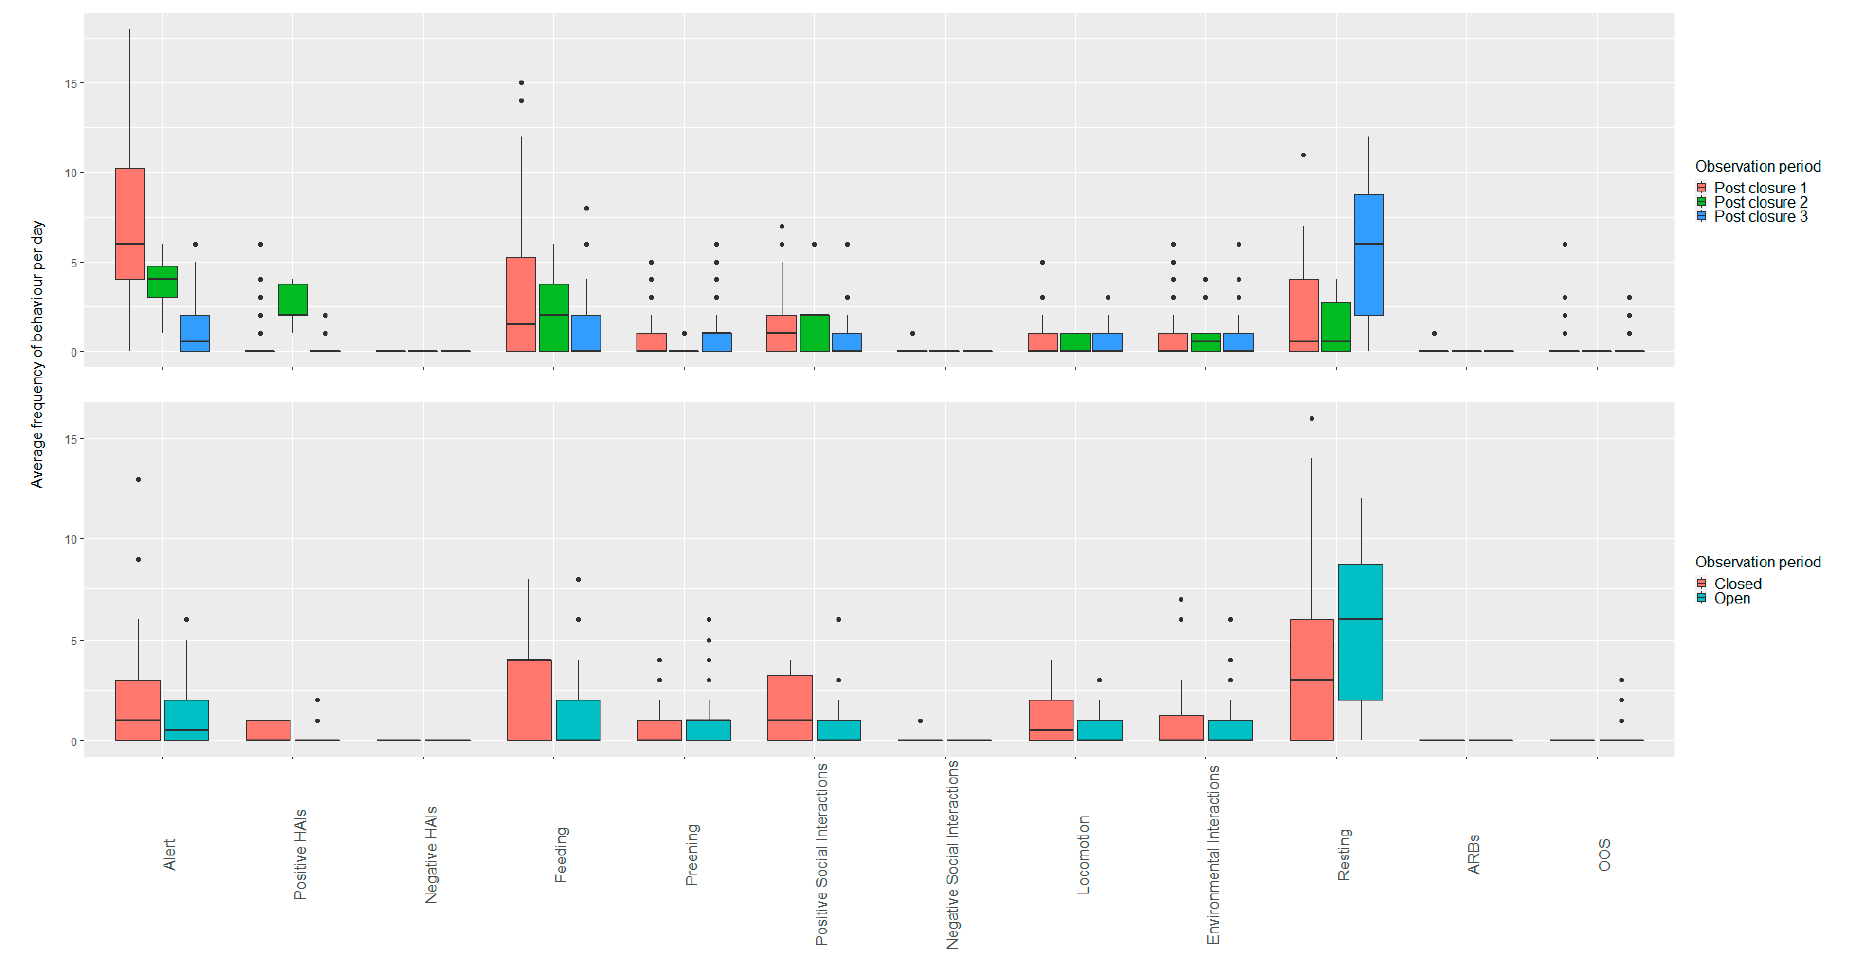
Figure 4. An overview of activity throughout the closure and reopening periods for the military macaw and blue and yellow macaw housed at White Post Farm. Dots represent outliers.